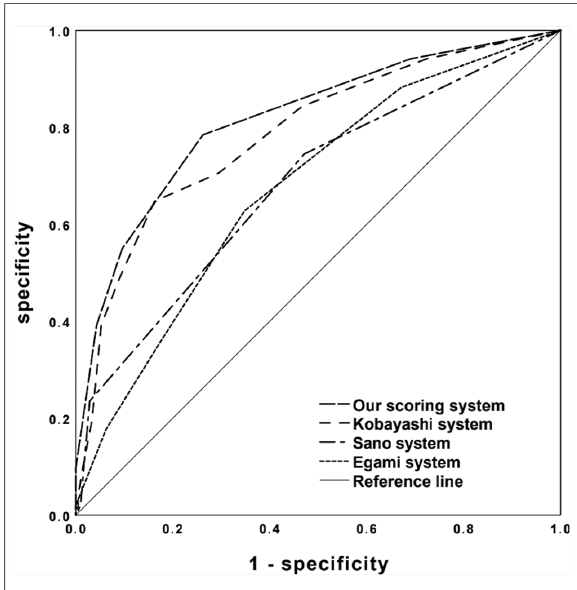
FIGURE 1 ROC curves of the new simple scoring model, Kobayashi, Egami, and Sano scoring systems in predicting IVIG non-responsiveness.